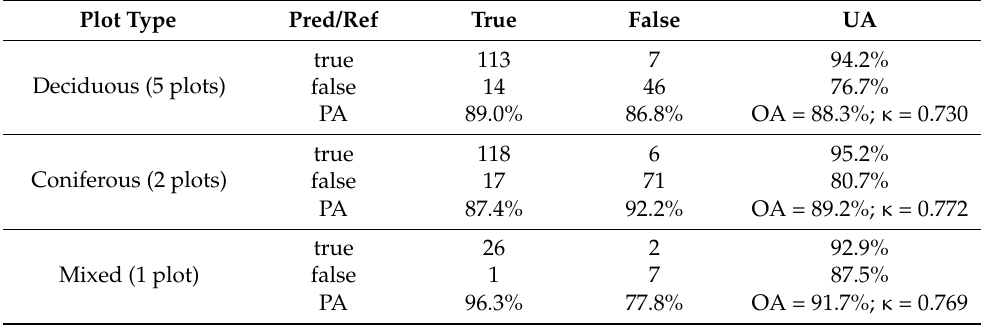
Table 8. The confusion matrix and performance metrics of the RF classification based on the test dataset with plots separated into deciduous, coniferous, and mixed